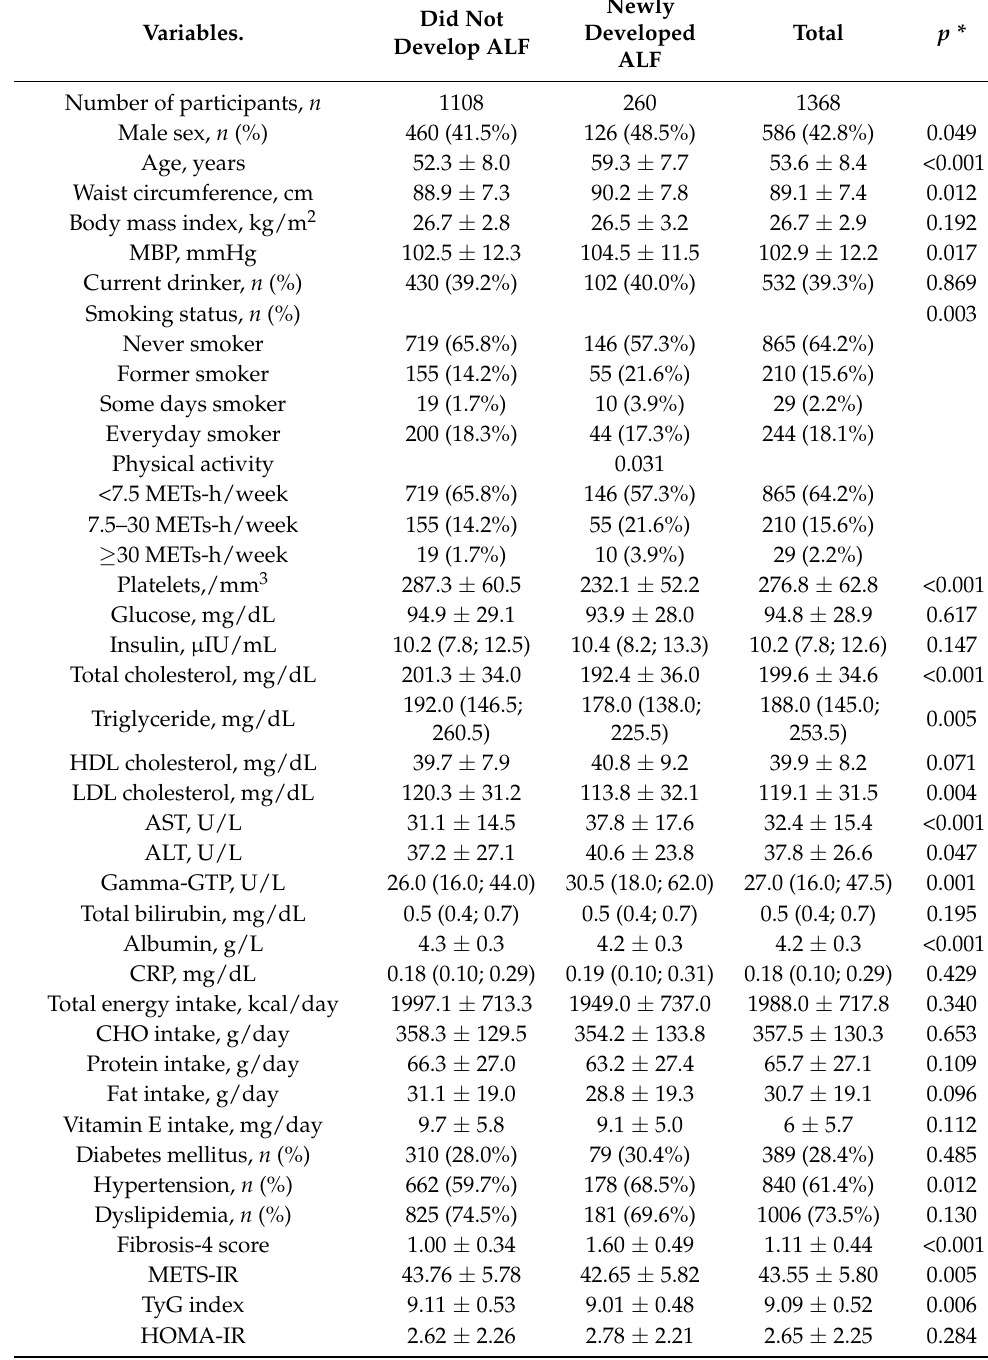
Table 1. Clinical characteristics of patients with NAFLD according to incident ALF. Did Not Variables. Develop ALF